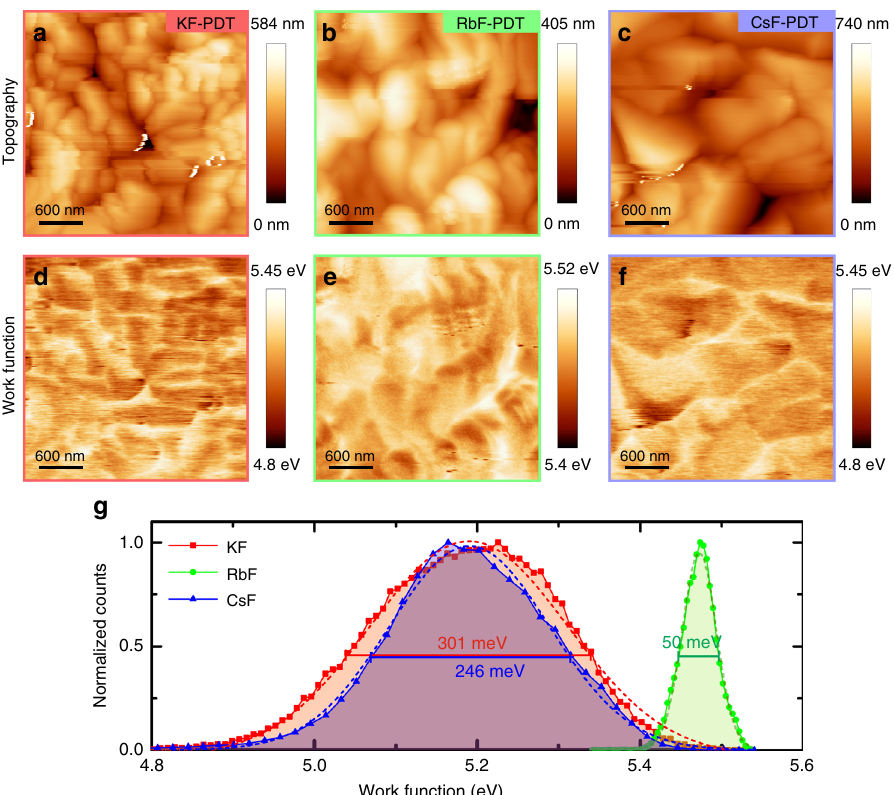
Fig. 1 Representative KPFM results on annealed and rinsed AlkF-PDT CIGSe absorbers. From left to right the data correspond to KF-, RbF-, and CsF-PDT. a – c Topography images, d – f simultaneously acquired work function maps measured under dark conditions, and g histograms extracted from the work function maps; dashed lines indicate Gaussian fi ts and the bars with the numbers the spread at 1/ e of the peak maximum